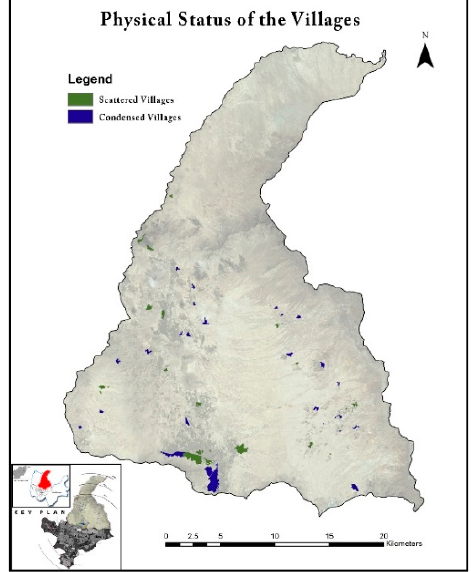
Figure 6. Physical status of the villages.